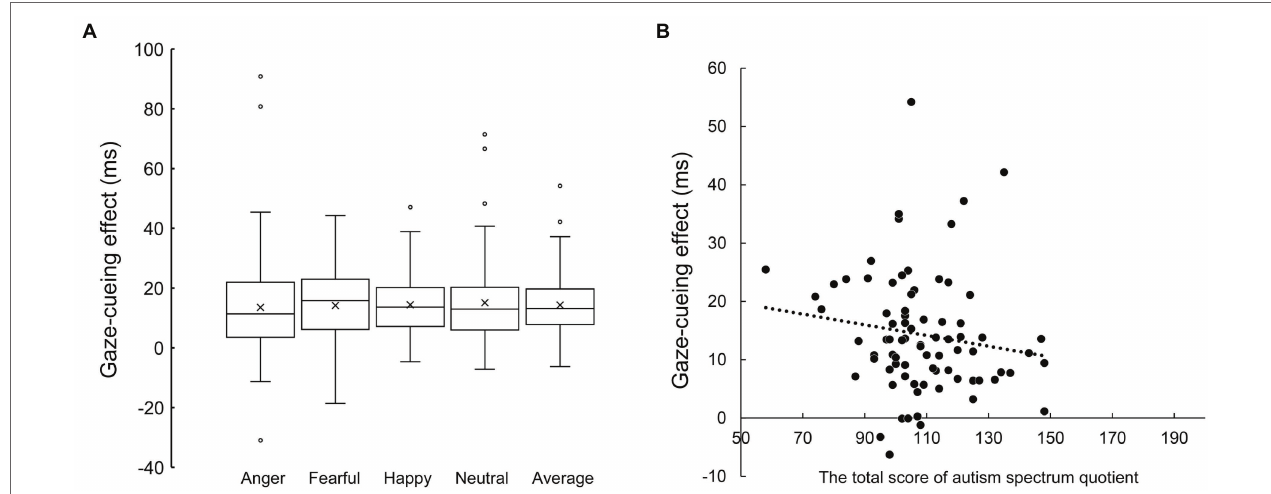
FIGURE 2 | (A) The gaze-cueing effect of each emotion condition and their average. (B) Scatterplot between the total score of the autism-spectrum quotient (horizontal axis) and the average gaze-cueing effect across the emotional and neutral face